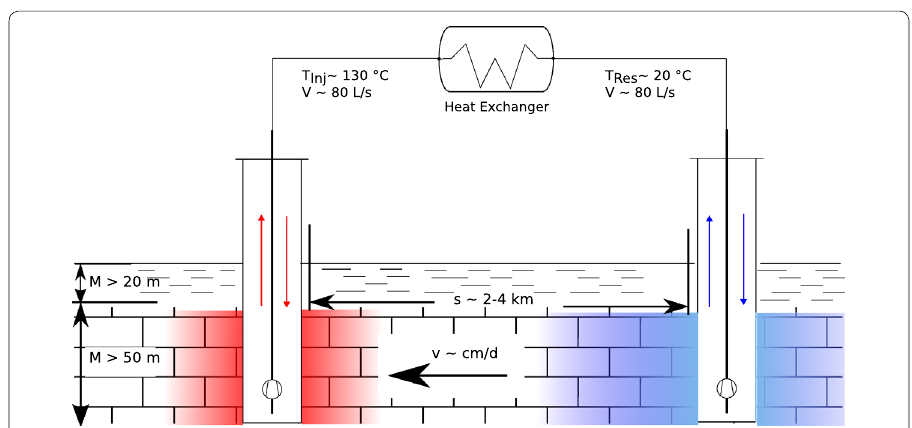
Fig. 1 Setup of a typical heat storage